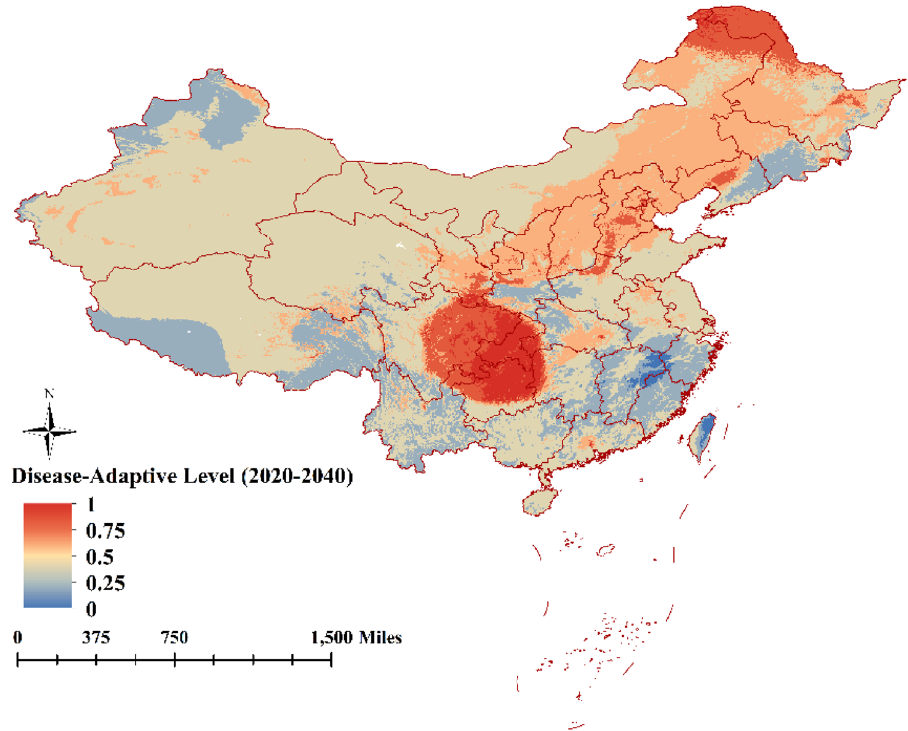
Figure 6. The model predicts areas suitable for ASF from 2020 to 2040 (The map is made by ArcGIS10.2 https:// www. esri. com/ and R 4.1.3 software https:// mirro rs. bfsu. edu. cn/ CRAN/).